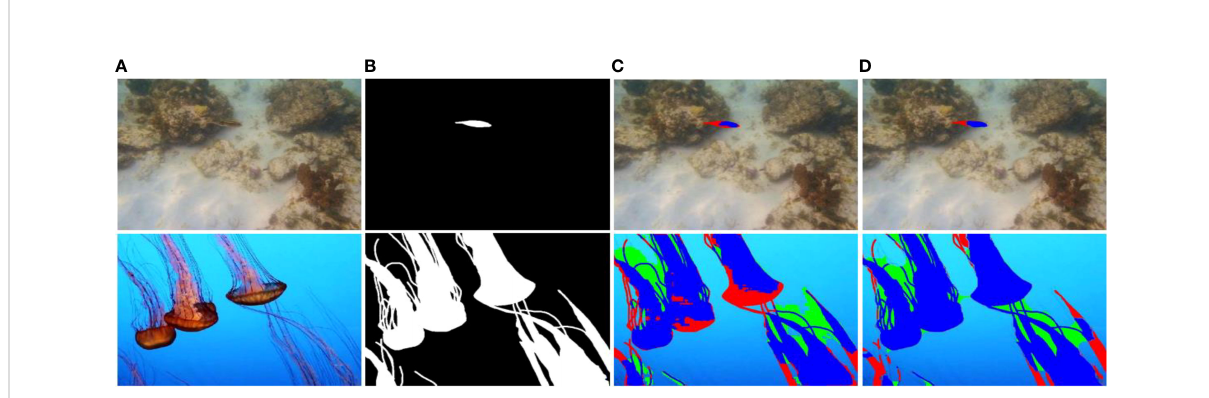
FIGURE 11 Poor segmentation visual results by EFS-Net and MFAS-Net on the SUIM dataset (A) original test image, (B) ground truth image, (C) segmented images achieved by applying EFS-Net, and (D) segmented images achieved by MFAS-Net (the fp and tp pixels are referred by green and blue colors, respectively. Pixel representation for fn is done with red